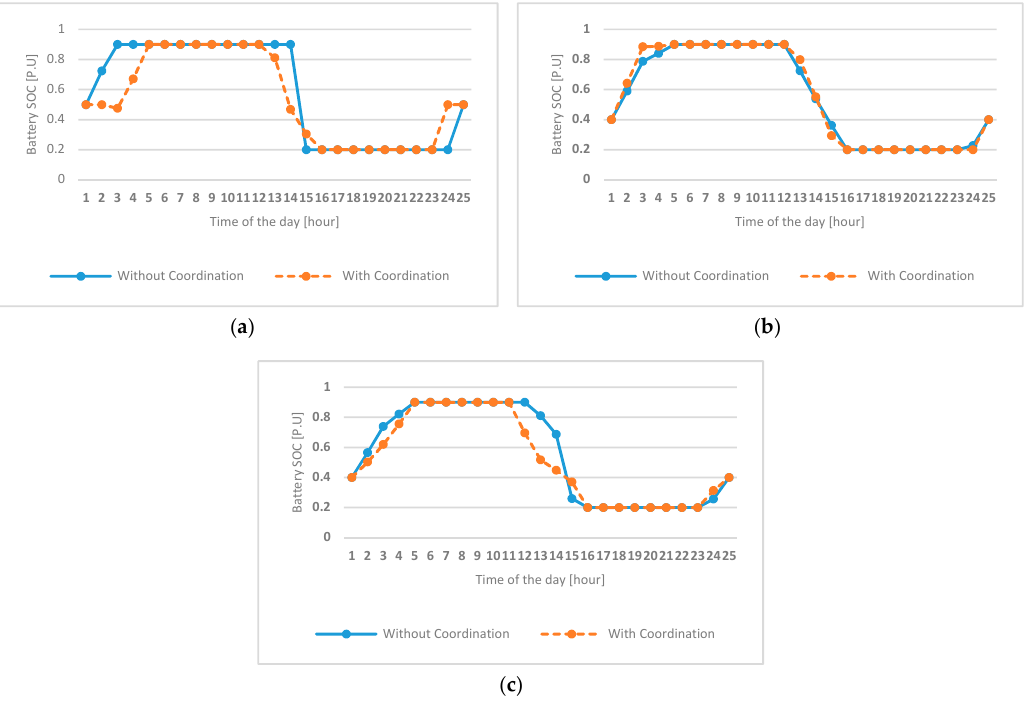
Figure 9. The amount of the power sharing in each microgrid ( a ) MG1, ( b ) MG2, ( c ) MG3.